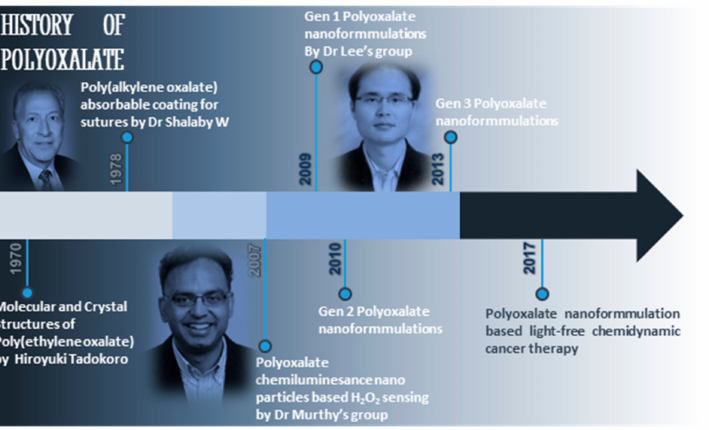
Figure 3. History of polyoxalate and co-polyoxalate.